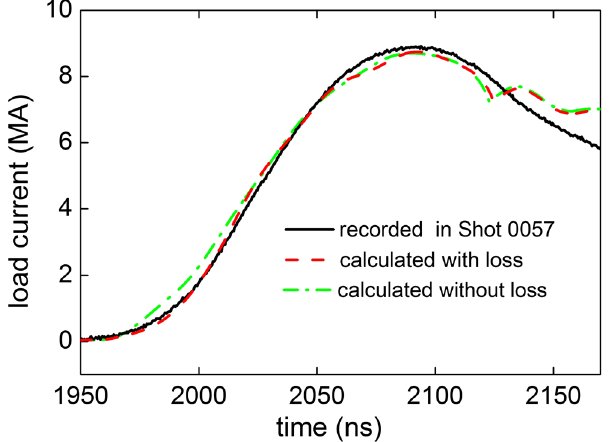
FIG. 7. Load current comparison of PTS shot 0057 and FAST calculations. The black solid line represents current recorded in the experiment, the red dashed line and the green dash dotted line represent calculated results with and without the loss mechanism. The consistency between the recorded result and the calculated result with loss mechanism suggests that the magnetic insulation criterion in the calculation is reasonable. The difference between the two calculated curves indicates that the current loss before magnetic insulation establishment occurs.